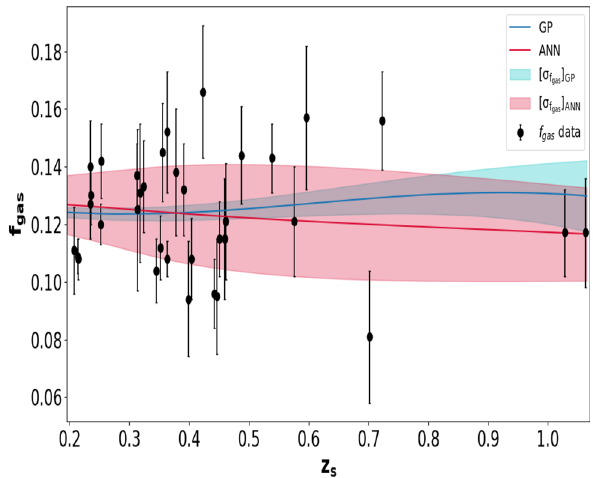
Fig. 9 A comparison between the Gaussian Processes reconstruction and Artificial Neural Networks (ANN) reconstruction of the gas mass fraction at z s for the Intermediate Mass range sample. The shaded regions show the 1 σ error bars from both the reconstruction techniques